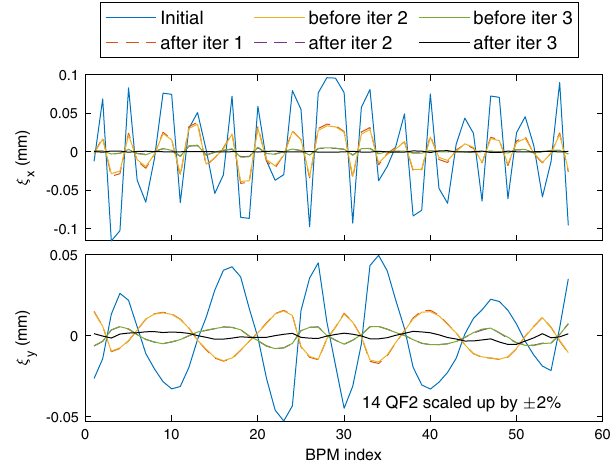
FIG. 11. The measured IOS by 14 QF magnets in a SPEAR3 experiment during three iterations of correction. The quadrupole gradient changes are (cid:3) 2% alternately.